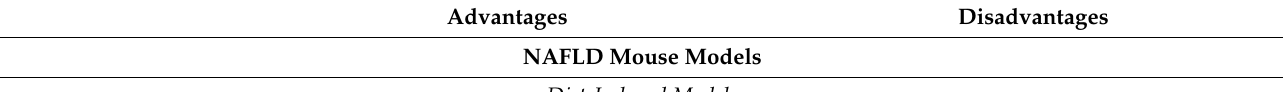
Table 1. Key advantages and disadvantages of animal models that are commonly utilized for NAFLD research, according to the stage of the disease they